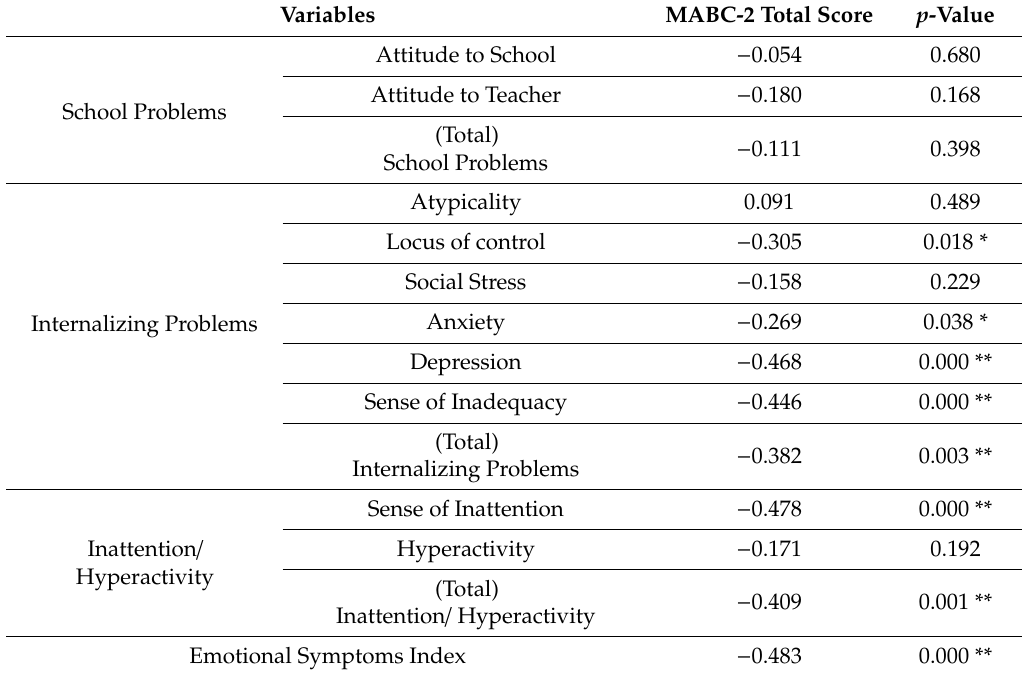
Table 6. The association of motor coordination skills and emotional